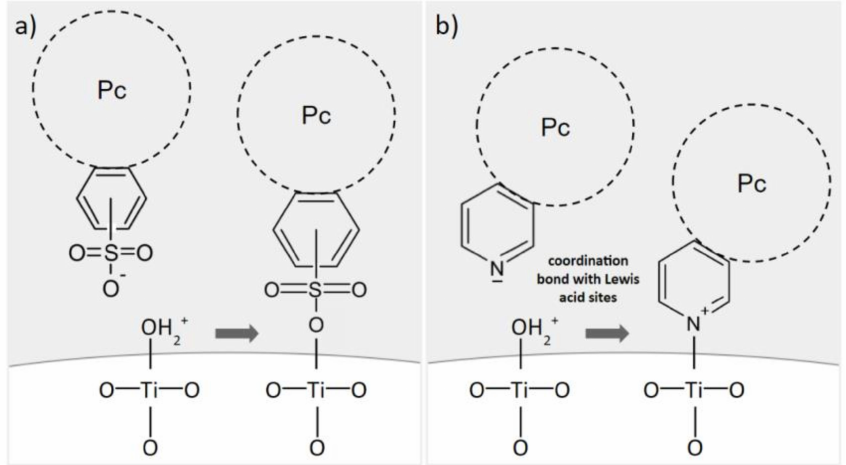
Figure 7. Proposed anchoring modes for ( a ) sulfonyl and ( b ) pyridyl peripheral groups of phthalo- cyanines on TiO 2 surface during the chemical deposition process below the TiO 2 point of zero charge (pH = 3–4). Based on